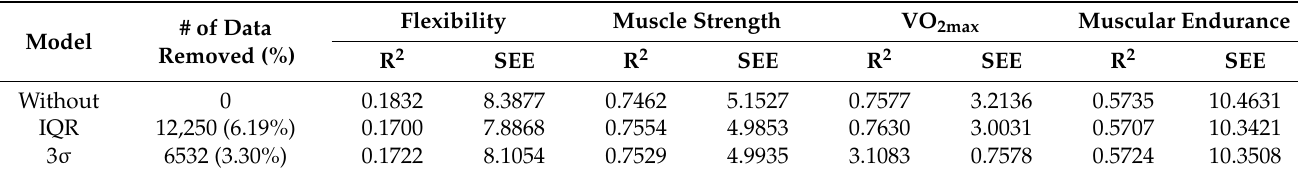
Table 4. Comparison of estimation accuracy according to the outlier removal.